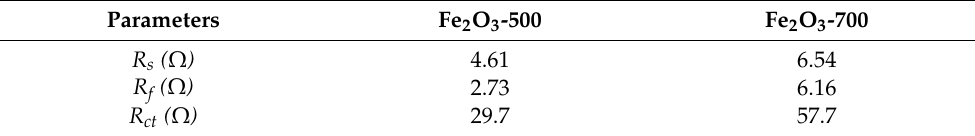
Table 1. Simulated resistance values ( R s , R f , R ct ) of Fe 2 O 3 -500 and Fe 2 O 3 -700